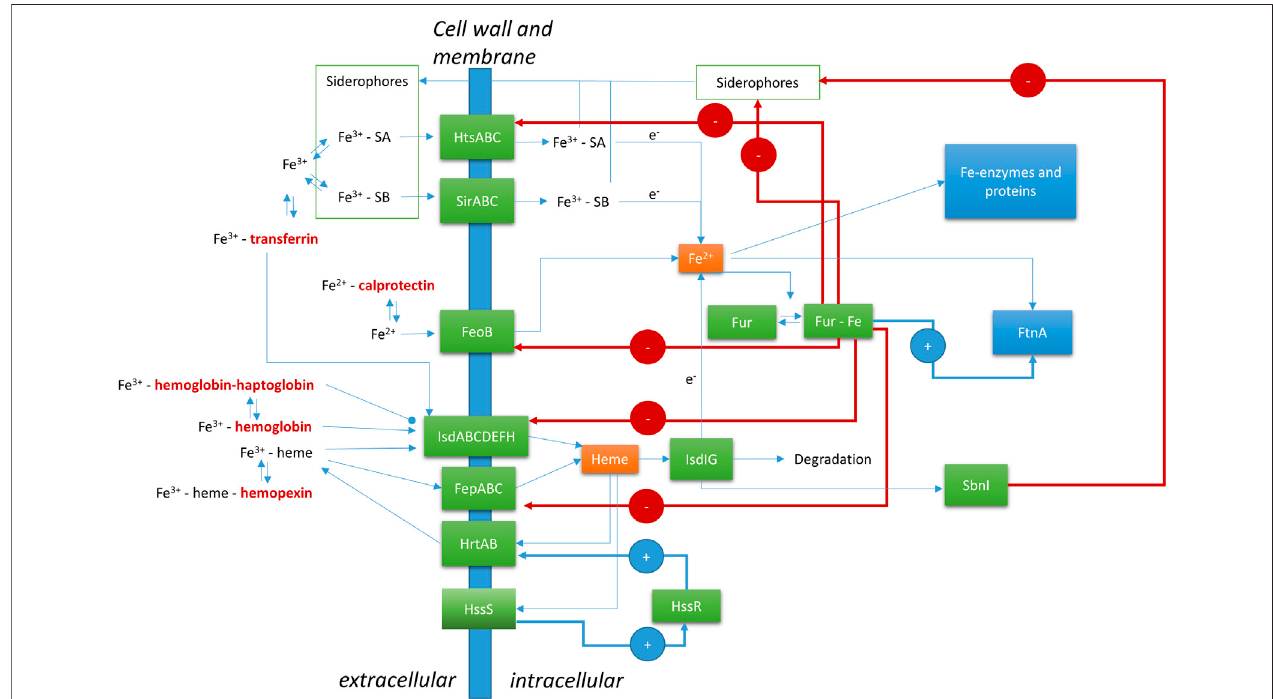
FIGURE 1 | Regulation of Fe by Staphylococcus aureus at the host-microbe interface. FeoB, ferrous Fe transporter; FepABC, Fe dependent peroxidase transporter; FtnA, ferritin; Fur, ferric uptake regulator; HrtAB, heme regulator transporter ef fl ux pump; HssR, heme sensing two-component regulator regulatory protein; HssS, heme sensing two-component regulator sensor protein; HtsABC, heme transport system involved in Fe-SA uptake; IsdABCDEFGHI, iron-regulated surface determinantsystem;SA,StaphyloferrinA;SB,StaphyloferrinB;SbnI,L-serinekinaseandhemeresponsiveregulatorofSBbiosynthesis.Human(host)proteinsare in bold and dark red